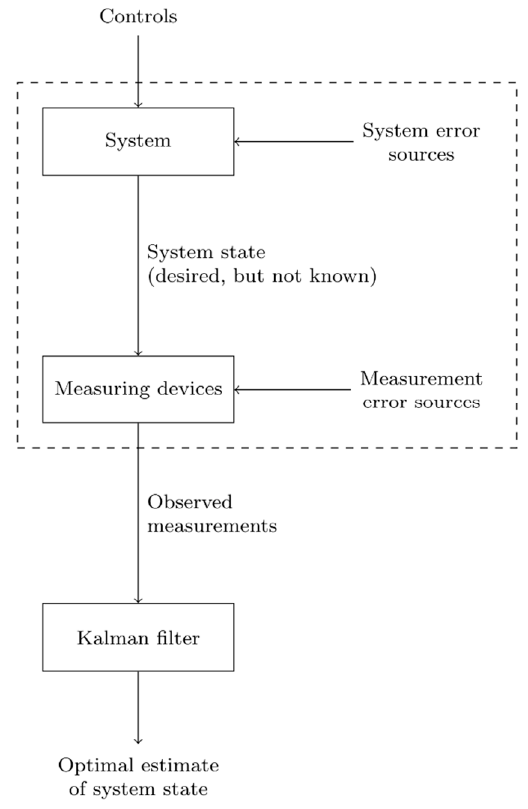
Figure 1. Scheme of applying the Kalman filter.